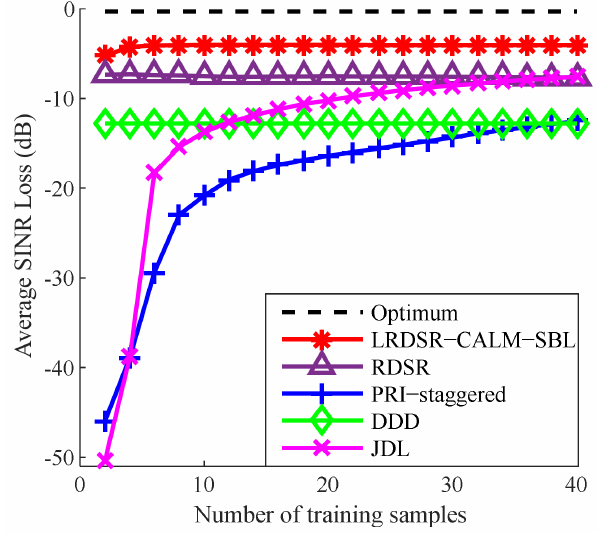
Figure 10. The average SINR loss against the number of samples.